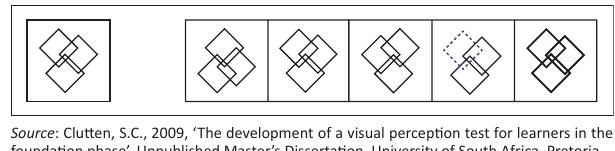
FIGURE 1: Example of an item from the visual discrimination subtest of the visual perceptual aspects